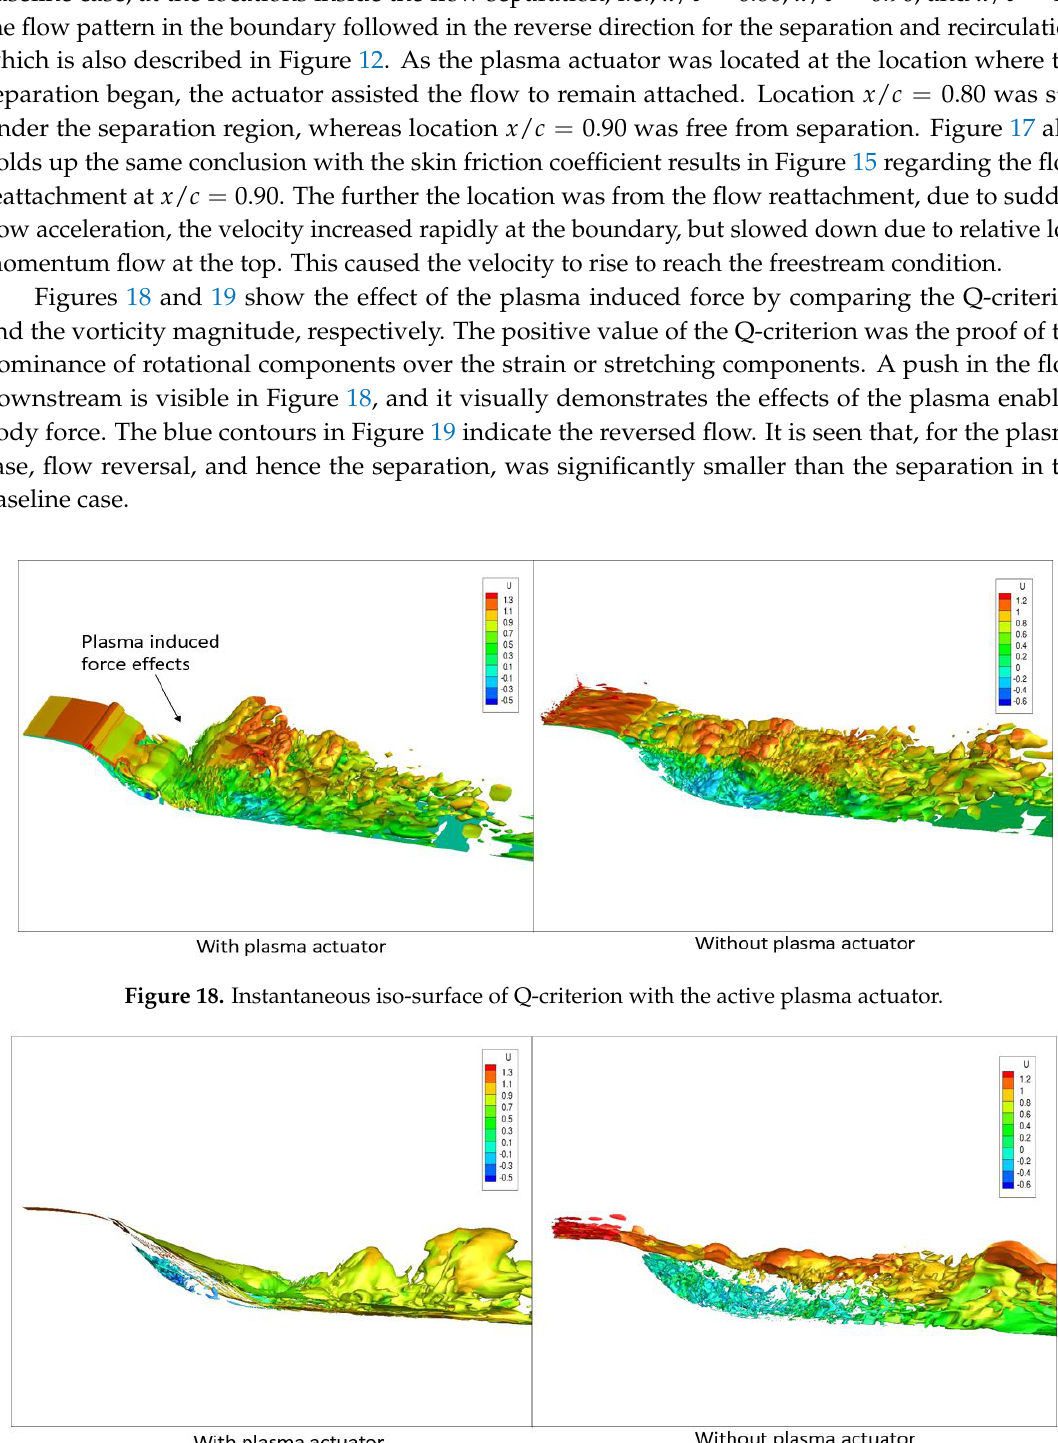
Figure 19. Vorticity magnitude with the active plasma